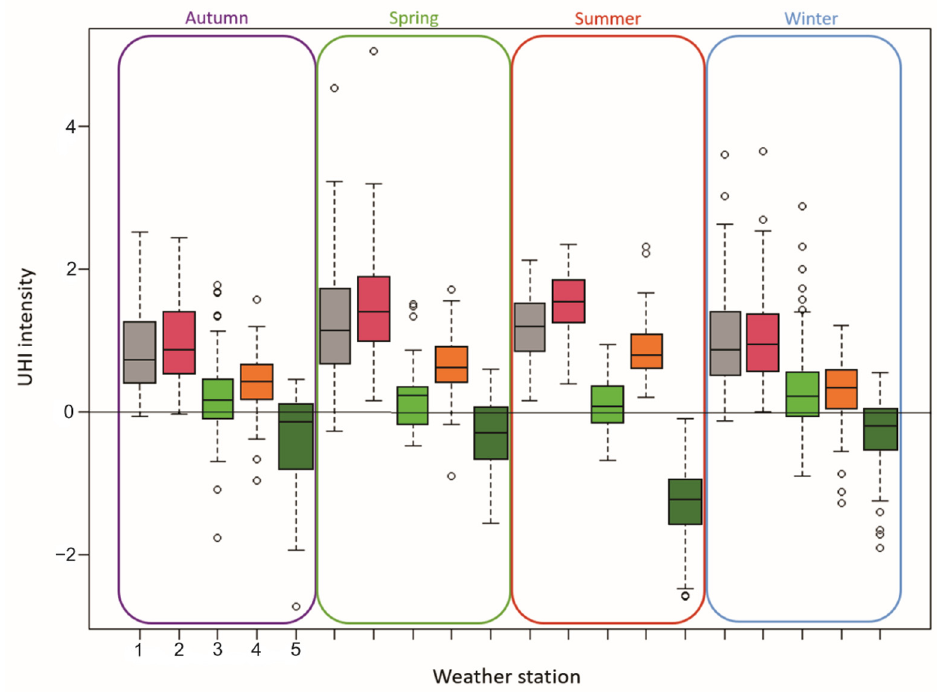
Figure 4. UHI intensity by season and UA category (local climate zone). 1 = the medieval city center (Industrial, commercial, public, military, and private units), 2 = the Melje industrial zone (Industrial, commercial, public, military, and private units), 3 = green urban area Mestni park (Green urban areas), 4 = the Tezno industrial zone (Industrial, commercial, public, military, and private units), 5 = Stražun forest (Forests).